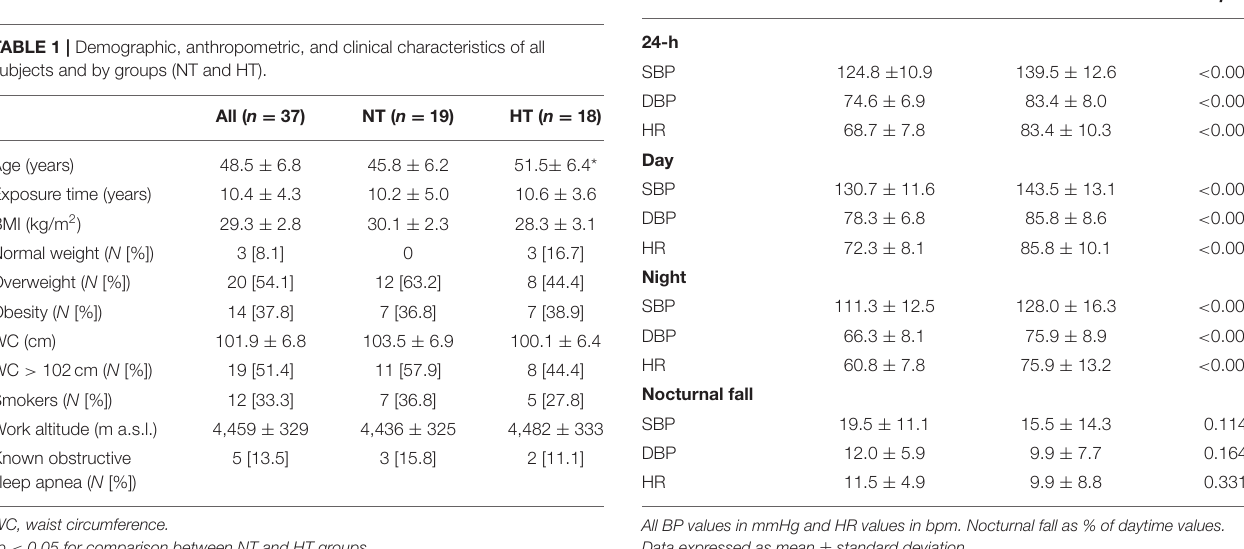
( Table 4 ). A borderline significant difference between groups